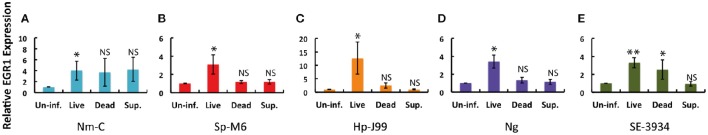
Bacterial viability and direct contact between bacteria and the host cells affect upregulation of EGR1. Induction of EGR1 was monitored by qPCR after infection of the host epithelial cells with live or dead bacteria. Dead bacteria were obtained by heat treatment at 95°C for 10 min. Viable counts were used to ensure complete killing of the bacteria. The role of bacterial contact with the epithelial cells in the EGR1 induction was studied using a 0.4 μm Millicell filter, which helps to physically separate the bacteria and host cells, but still allows diffusion of secreted factors in the cell growth media (Sup.). (A) Pharyngeal FaDu cells infected with N. meningitidis (Nm-C). (B) Pharyngeal FaDu cells infected with S. pyogenes (Sp-M6). (C) Gastric AGS cells infected with H. pylori (Hp-J99). (D) Cervical ME180 cells infected with N. gonorrhoeae (Ng). (E) Intestinal Caco-2 cells infected with S. Enteritidis (SE3439). Bacteria were added to a MOI of 100 in all experiments. The data was analyzed at 2 h post infection for Nm-C, Sp-M6, SE3439, and Hp-J99. The data was analyzed at 4 h post infection of Ng.